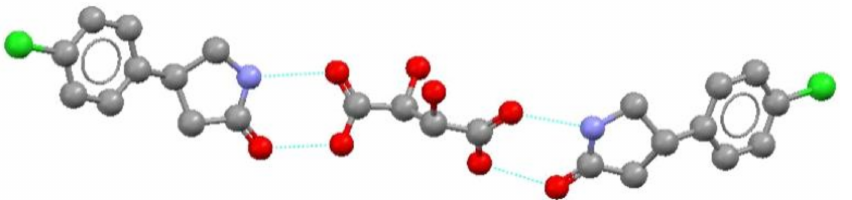
Figure 28. Resolution of optical isomers of 4-amino-p-chlorobutyric acid lactam (Baclofen ® ) by co-crystallization 4-amino-p-chlorobutyric acid lactam lactam [91].